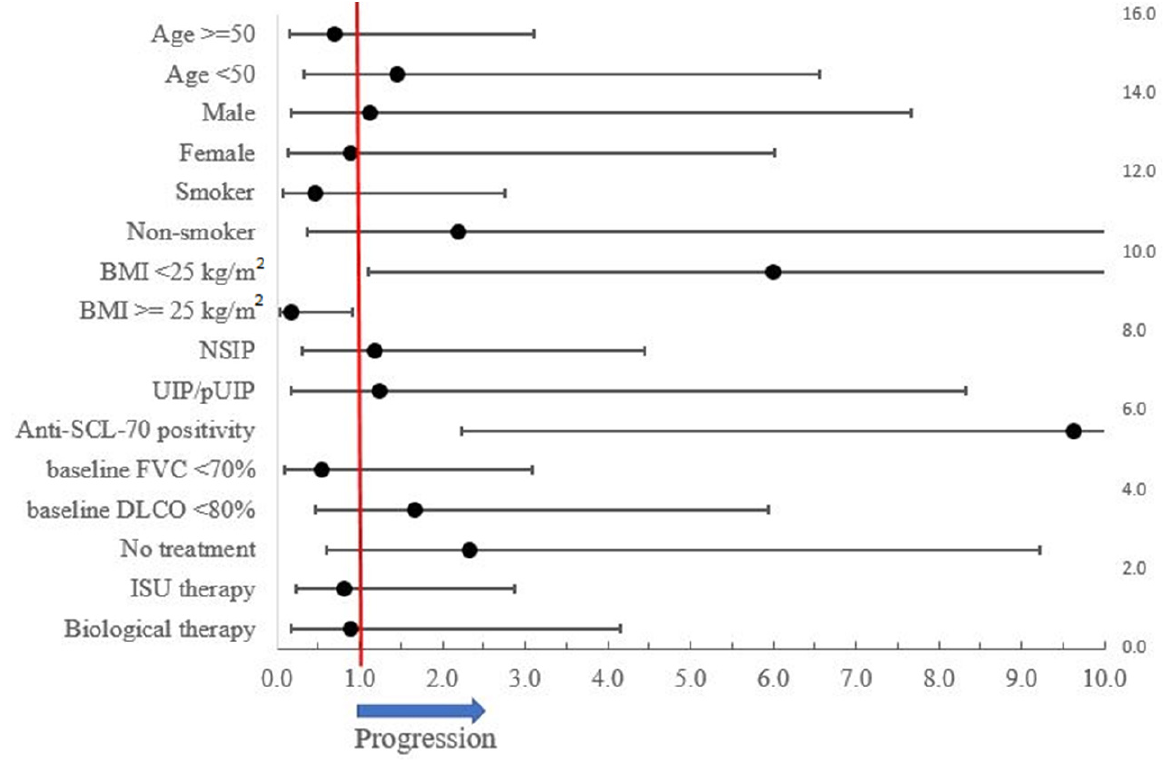
Figure 3. Risk factors of PF ‐ ILD progression.